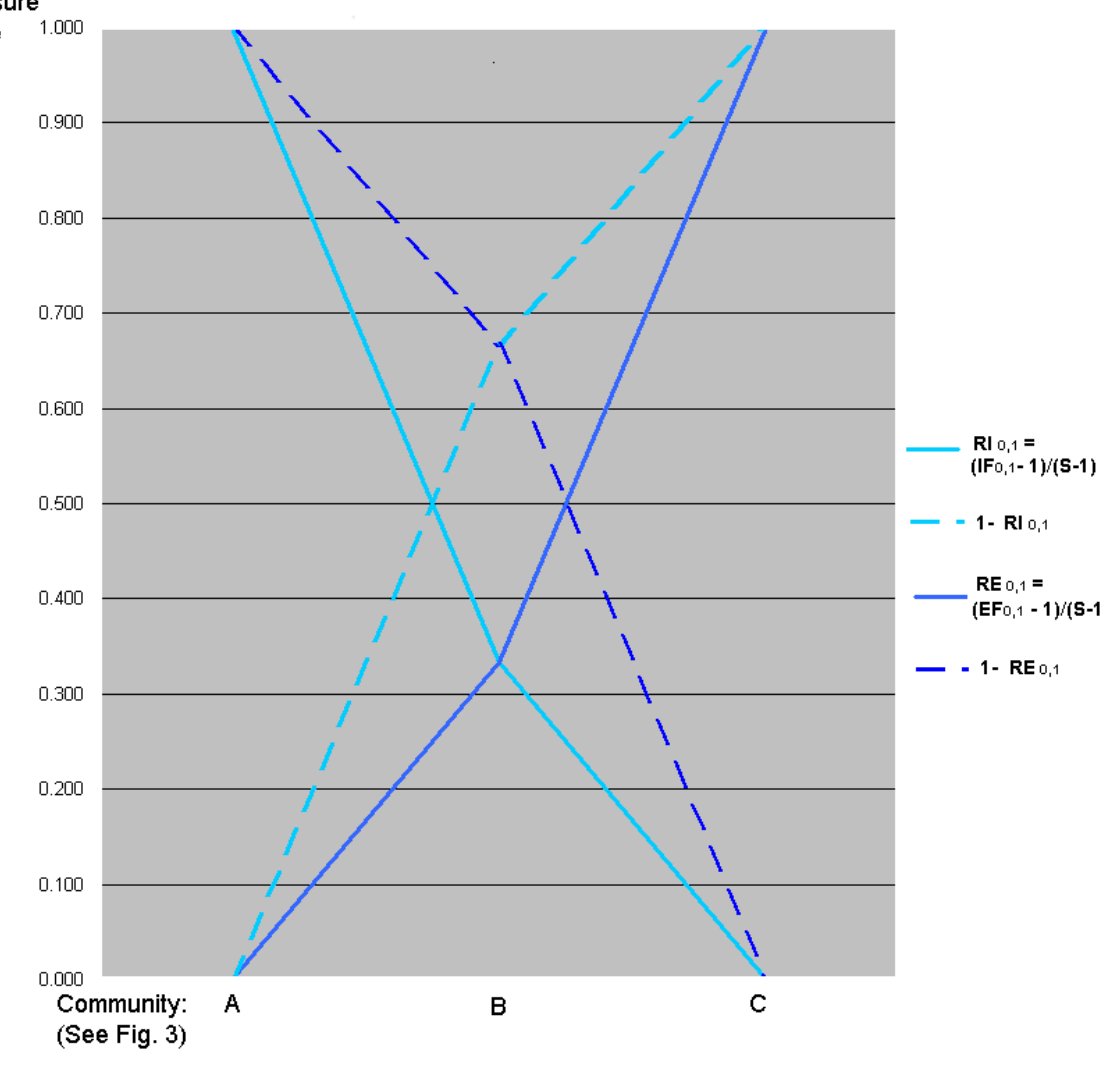
and relative inequality RI 0, 1